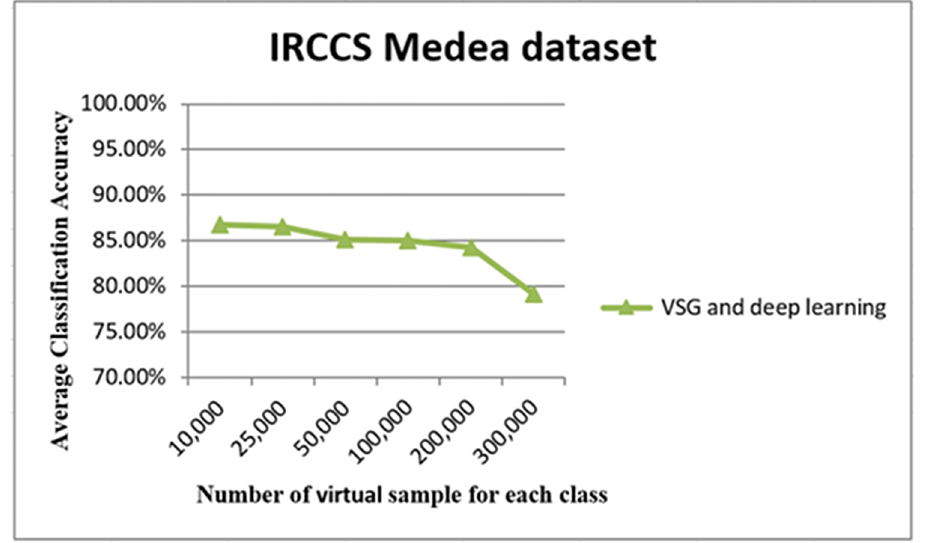
Figure 14. The accuracy using only the original five small training IRCCS Medea datasets. The x -axis of this graph shows the number of virtual samples, while average accuracy appears on the y